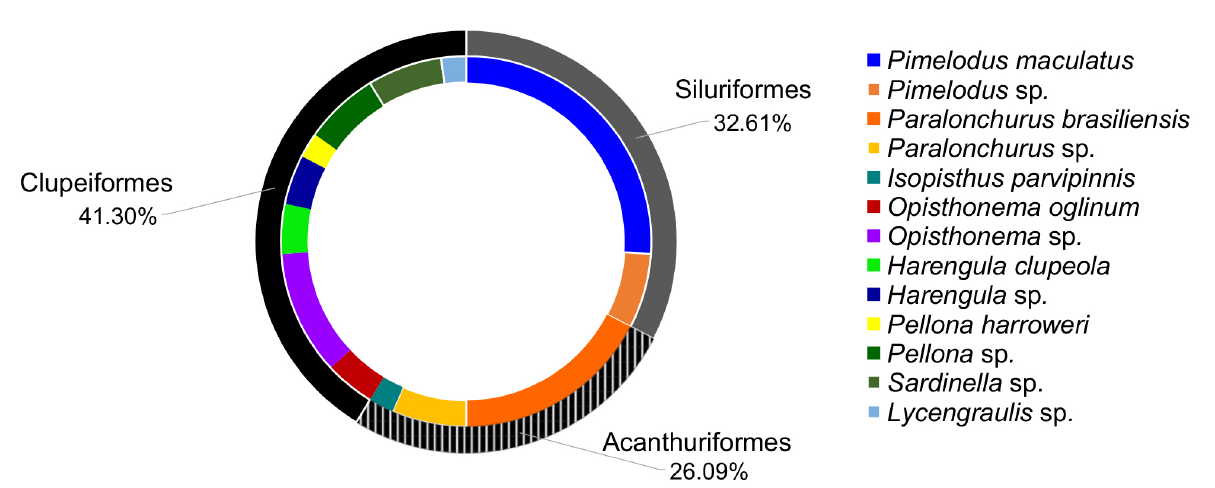
FIGURE 1 | Diagram showing the taxonomic composition of the prey items identified in the stomach of the largehead hairtail, Trichiurus lepturus , collected off the coast of São Paulo state in southeastern